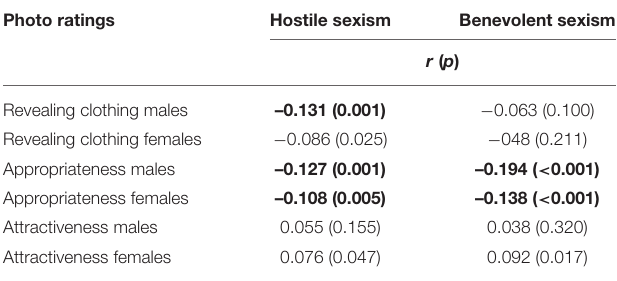
TABLE 2 | Partial correlations between Instagram photo ratings and ambivalent sexism in the female subsample. Photo ratings